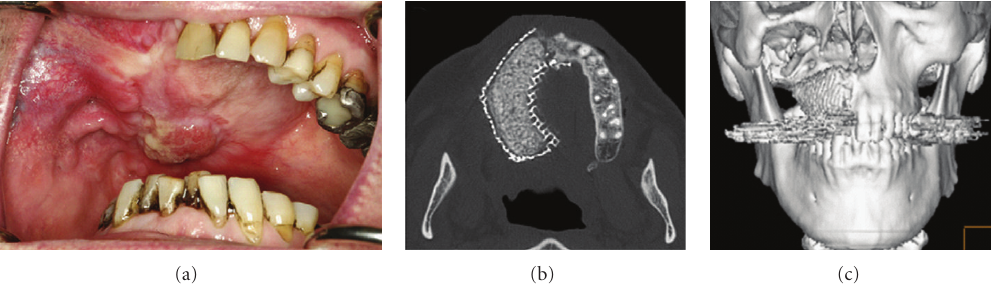
Figure 4: Two months postoperative results of the study by Mesimaki et al. Mesimaki et al. reconstructed a major maxillary defect in an adult patient using autologous adipose-derived MSCs (ASCs) combined with rhBMP-2 and β -TCP granules in a microvascular reconstruction surgery. Two months postoperative results indicate that (a) the rectus abdominis muscle has atrophied nearly totally and epithelialized almost completely. Only a small area in the molar region was nonepithelialized. A well-formed buccal sulcus is also noted. Axial (b) and 3D CT scans (c) show the shape and normal bone density of the new